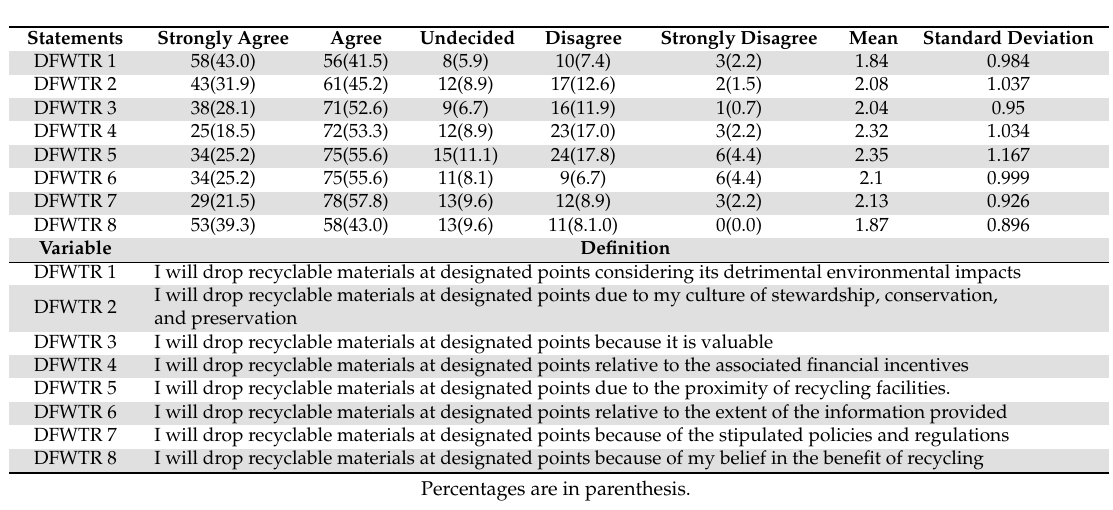
Table 2. Descriptive statistics of drivers for a households’ willingness to recycle.